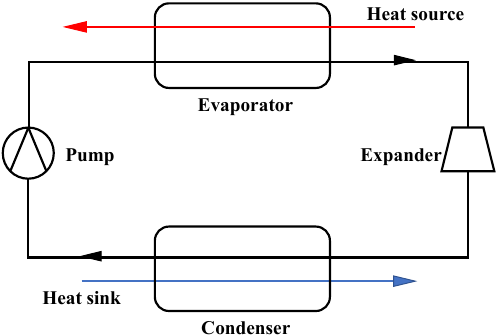
Figure 1. Schematic of a simple ORC system.